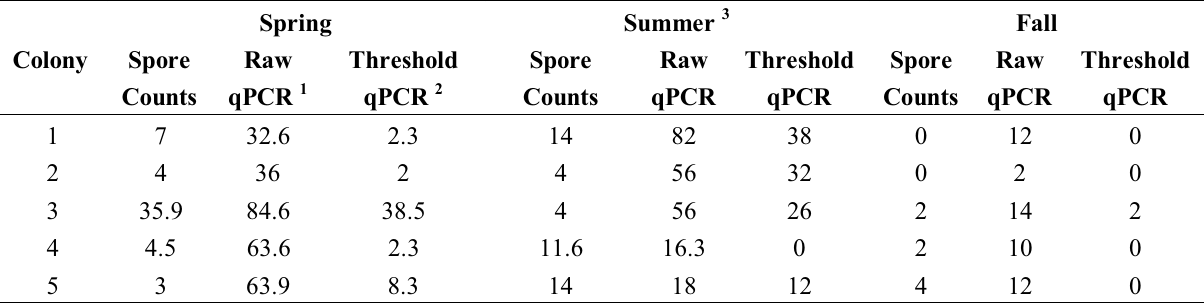
Table 3. Percentage of bees sampled from each colony determined infected by spore analysis and qPCR over 3 seasons. Spring Summer 3 Fall